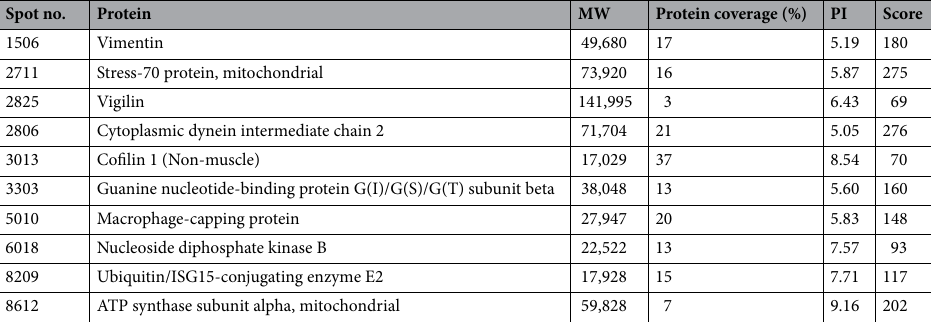
Table 1. Differentially expressed proteins in control and H 2 O 2 - exposed